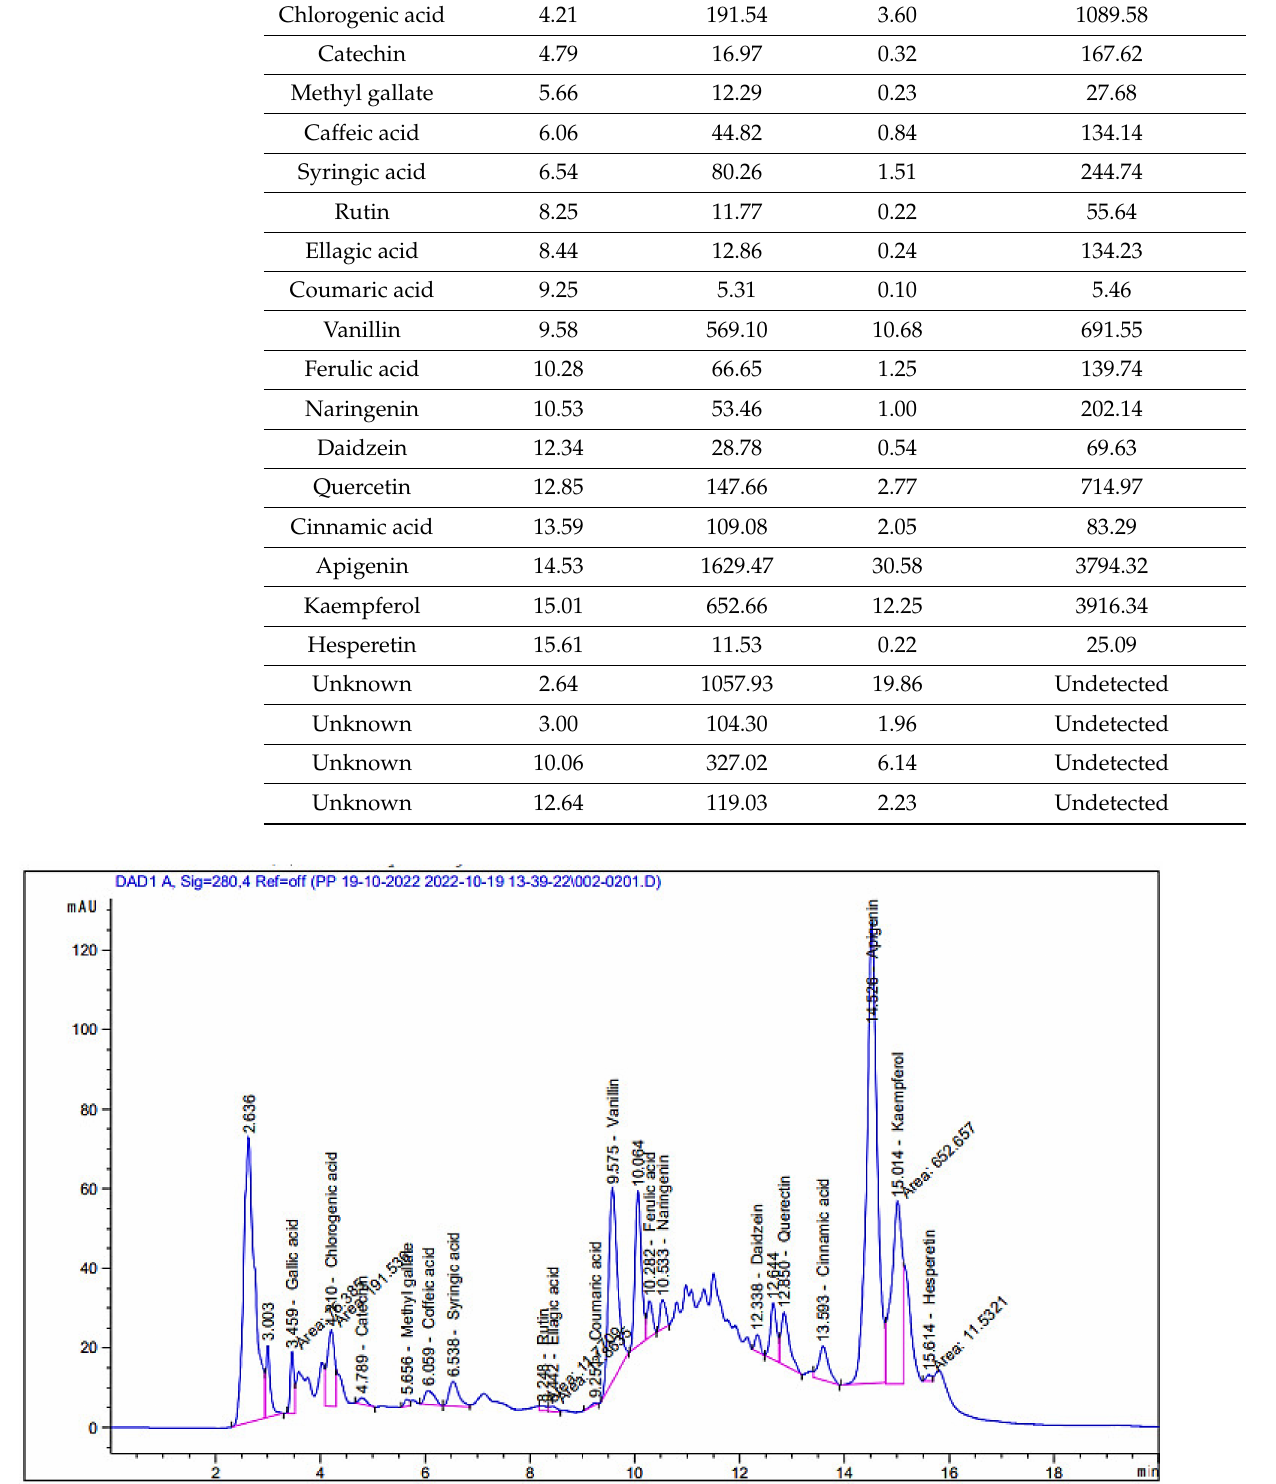
Figure 2. High-performance liquid chromatography chromatogram of polyphenolic and flavonoid compounds detected from Artemisia judaica